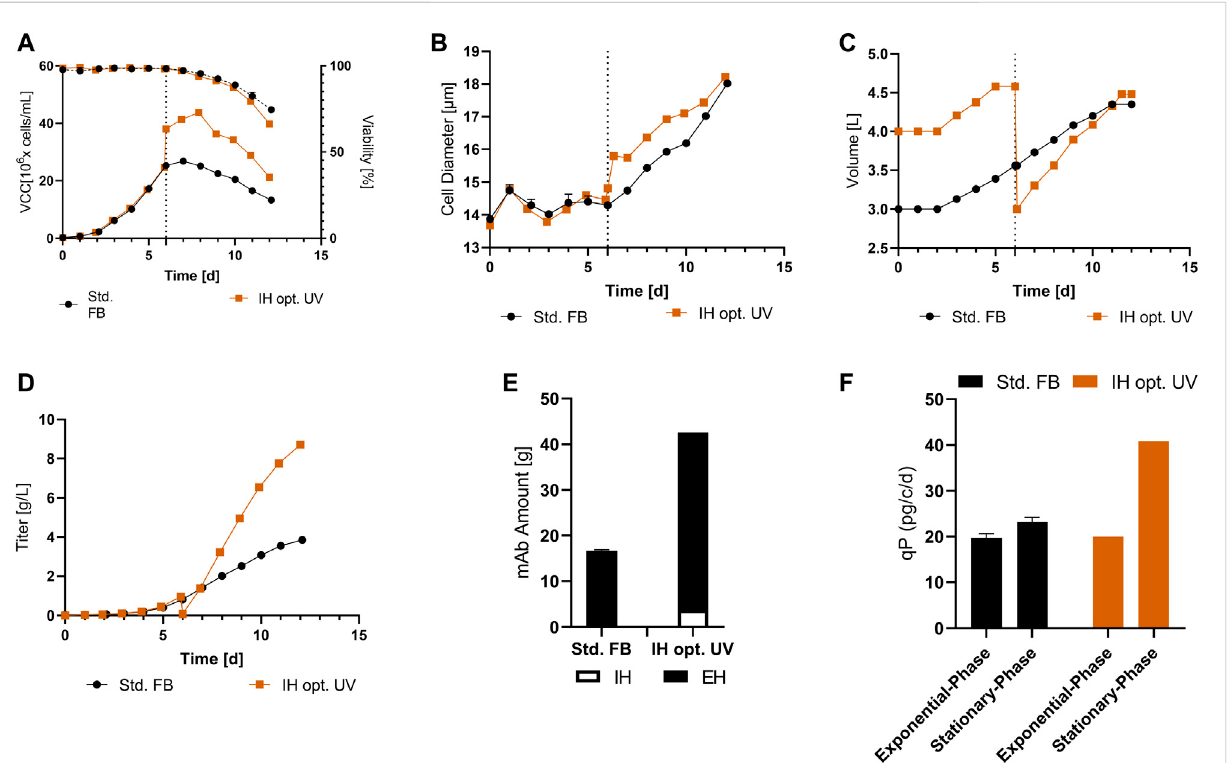
FIGURE 5 Cellular and expression parameters for the standard FB ( n = 2) and the optimized IH in a UniVessel cultivation (IH opt.; n = 1). (A) VCC (solid line) and viability (dotted line) for both approaches. (B) Diameter for over the course of cultivation. (C) Filling volume overtime for both experiments. (D) Titer overtime in (g/L) for std. FB and IH opt. (E) Total amount of produced mAb from IH and EH (end harvest) for each approach. (F) qP (pg/c/d) separated for the exponential phase (up to day six) and stationary phase (from day six to the end) for both experiments.